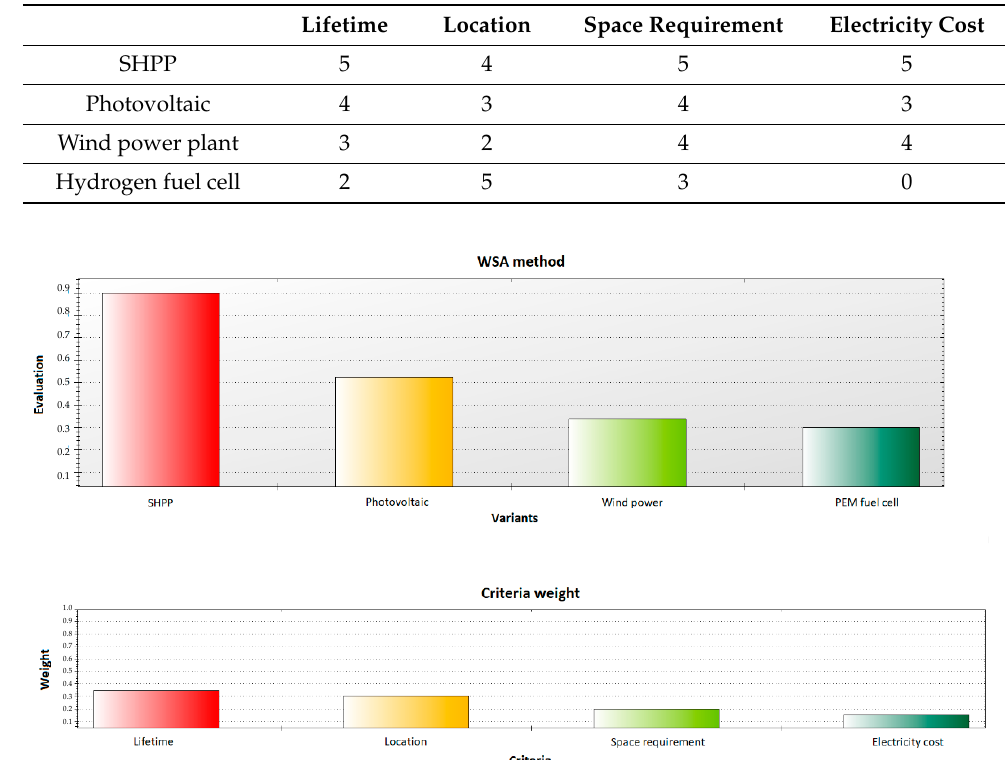
Figure 8. Results of the weighted sum approach method.